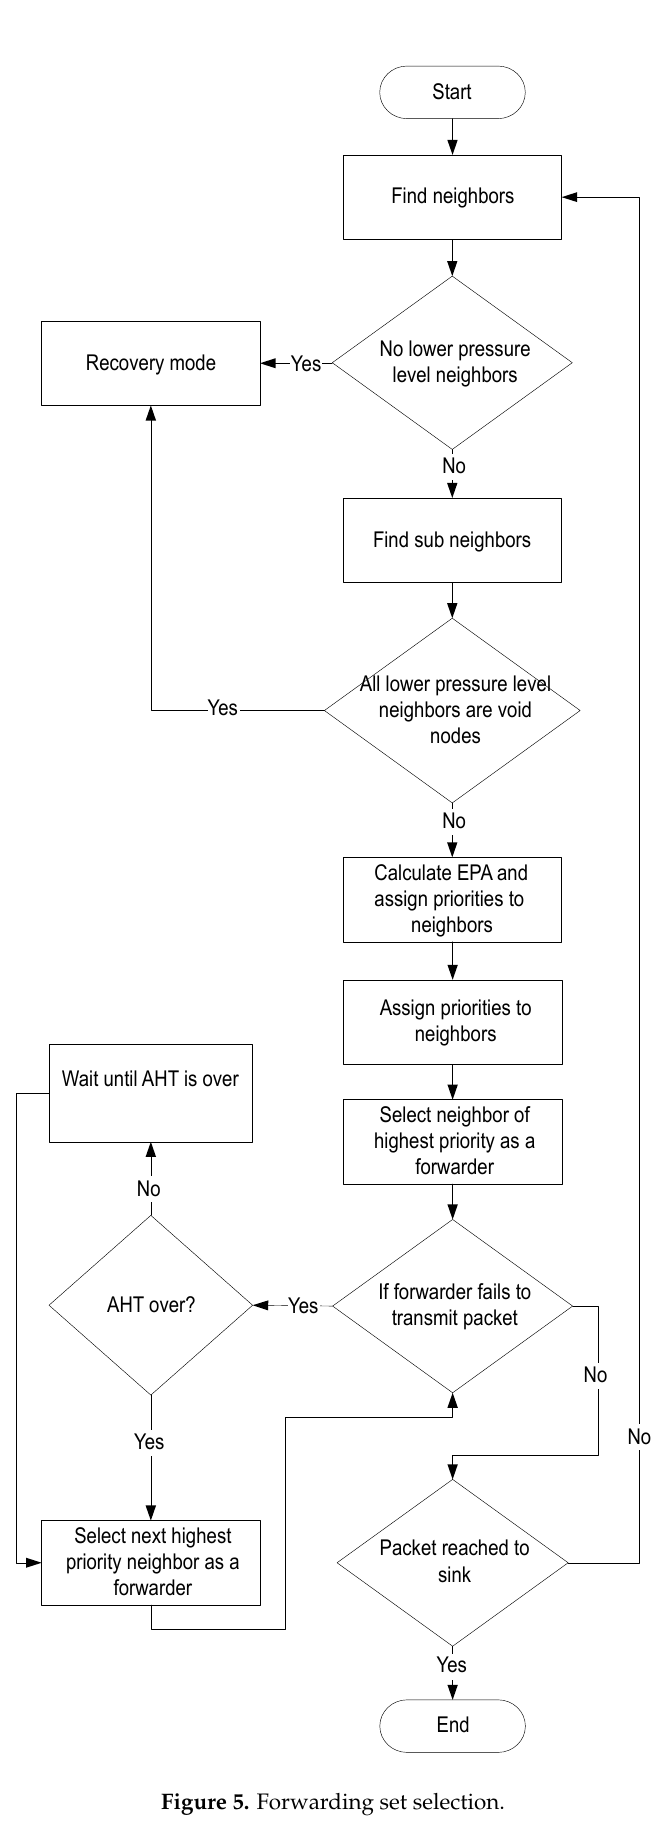
Figure 5. Forwarding set